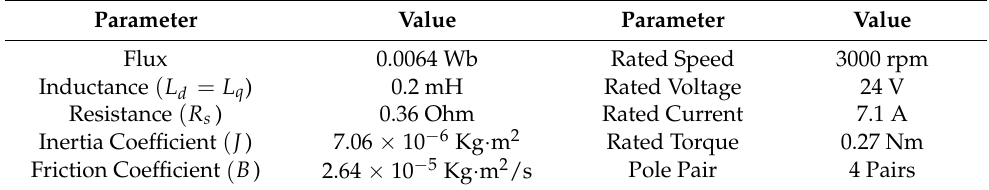
Table 1. PMSM parameters.